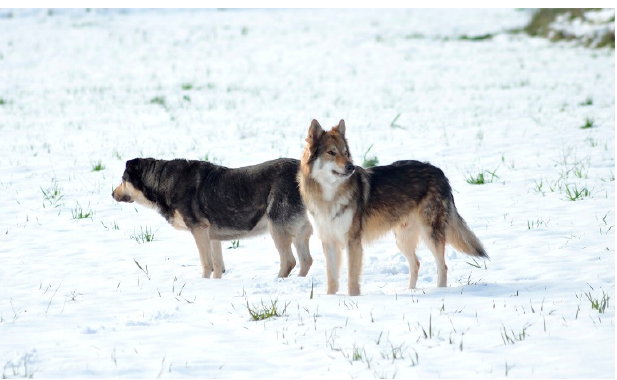
Figure 1. The female is looking at the little red male, asking him to increase the distance. The little red male is approaching in a curving but conflicting way; he has hackles and his face expresses tension. May be he is testing the reaction of the female, asking her to stand up; the female face expresses threat (she probably does not want to interact with him).